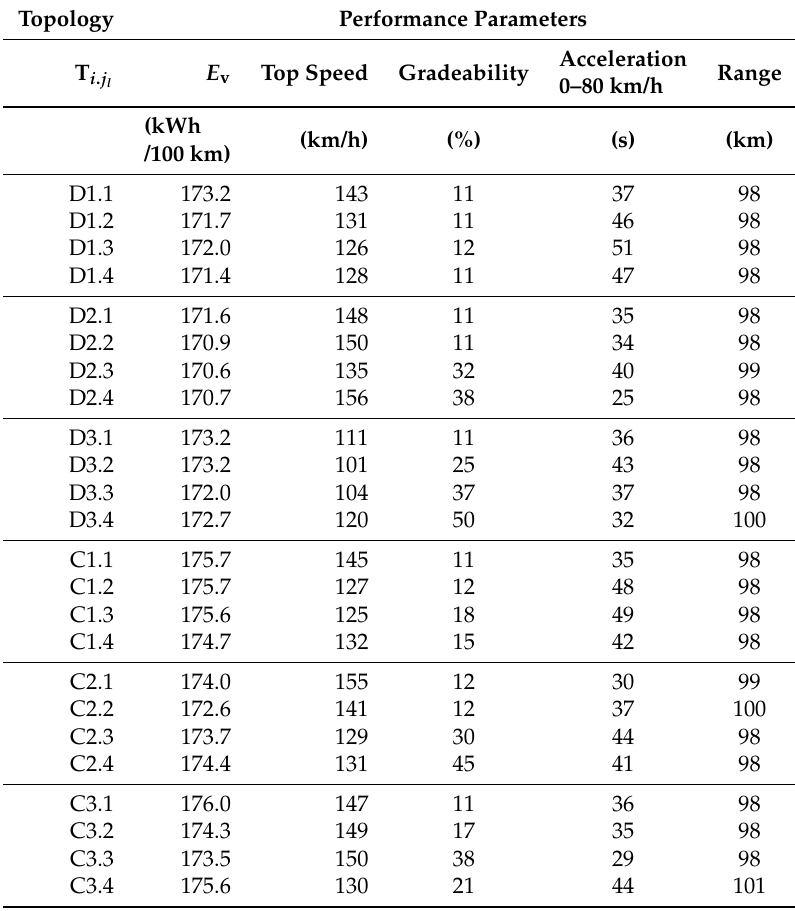
Table A2. Additional performance parameters for the powertrain configurations optimized for total-cost-of-ownership, as discussed in Section